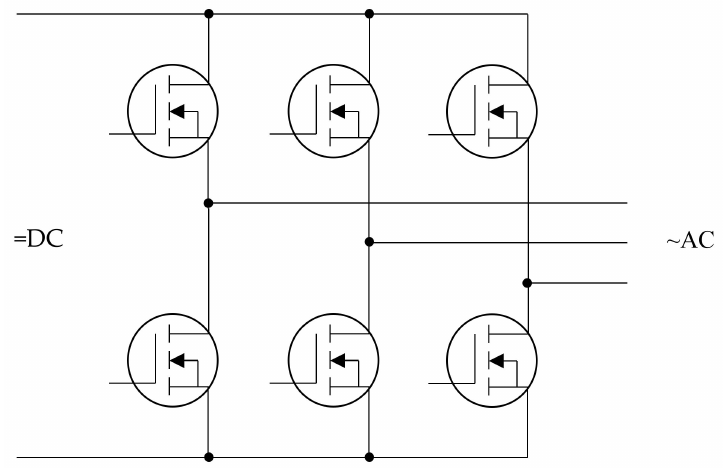
Figure 10. Three-phase bridge DC/AC